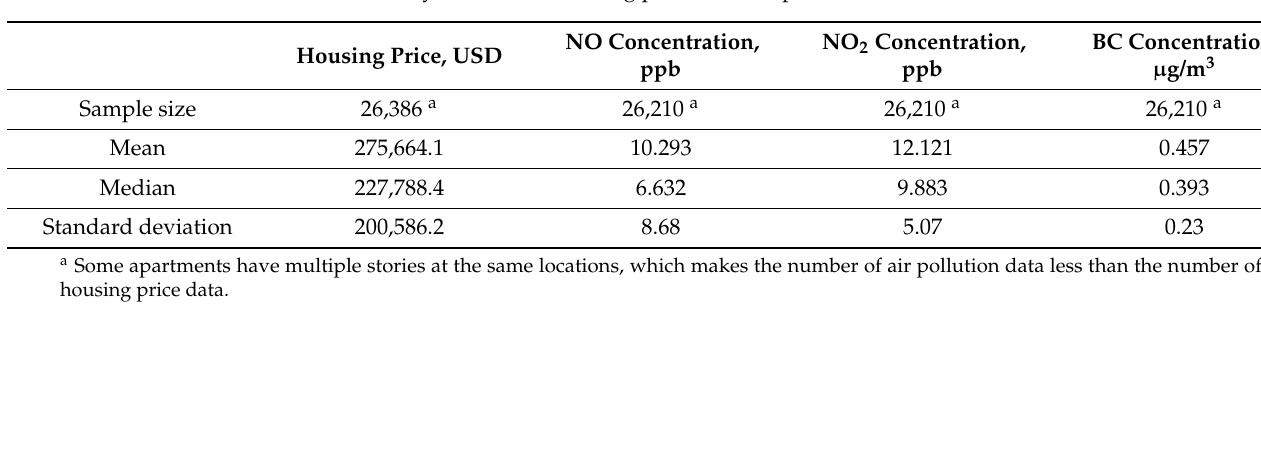
Figure 3. Distributions of housing prices ( A ), logarithm transformed of housing prices ( B ), and concentrations of NO ( C ), NO 2 ( D ), and BC ( E ). Table 1. Summary statistics of housing prices and air pollution concentration